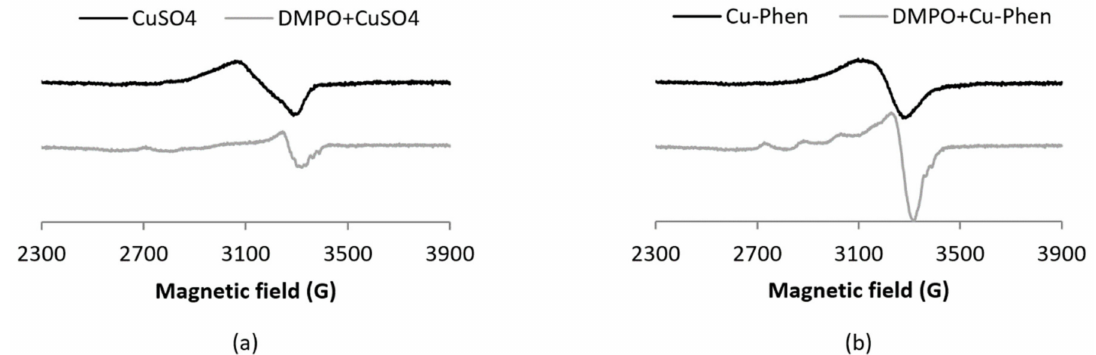
Figure 4. X-band EPR spectra at 100 K of ( a ) CuSO 4 with and without DMPO and ( b ) Cu–Phen with and without DMPO, [Cu] = 0.15 mM, [DMPO] = 60 mM. For a solution of copper with an equimolar amount of DMPO, i.e., 0.15 mM, the structuration is no longer visible (results not shown), indicating a low affinity of DMPO for